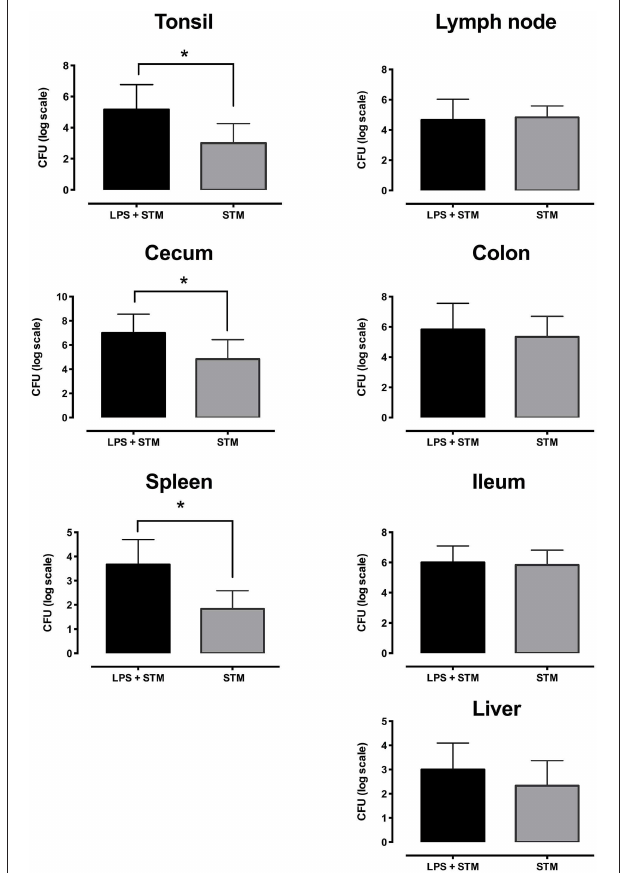
FIGURE 5 | LPS treatment raises STM14028 colonization of tonsils, cecum, and spleen of piglets. Recovery of STM14028 from different organs at 48h post infection of piglets treated with LPS and infected with STM14028 (LPS + STM group) or only infected with STM14028 (STM group). LPS-treatment increases the colonization of tonsils, cecum, and spleen but does not influence the colonization of mesenteric lymph nodes, colon, ileum, and liver of piglets after STM14028 infection. Data refer to one out of two separate experiments performed with comparable results. The differences between the groups were statistically significant ( * P ≤ 0.01 , Mann–Whitney unpaired t